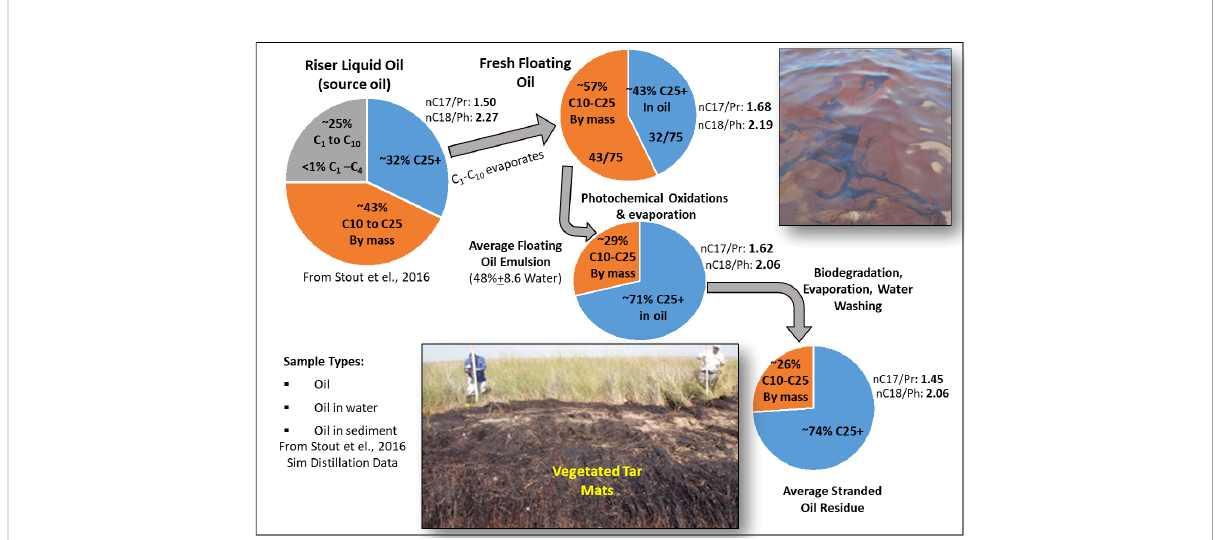
FIGURE 11 An overview of the bulk composition of Deepwater Horizon Oil calculated from simulated distillation data for the liquid source oil. The fresh fl oating oil sample was estimated from the chemical composition of target alkanes and PAH compounds, assuming that natural gas and very volatile compounds were rapidly lost during the transit of oil drops to the surface. The composition of average fl oating oil and average stranded oil was estimated from the target compound concentrations as presented in Stout et al., 2016, assuming 50% of the labile C 10 to C 25 fraction was lost and most of this 50% was converted to oil soluble oxy hydrocarbons that become a component of the C 25 + fraction (Ward et al., 2018). Once stranded, oil residues were subjected to biodegradation with daily water washing by tidal fl ushing converting components of the labile C 10 to C 25 fraction into CO 2 and